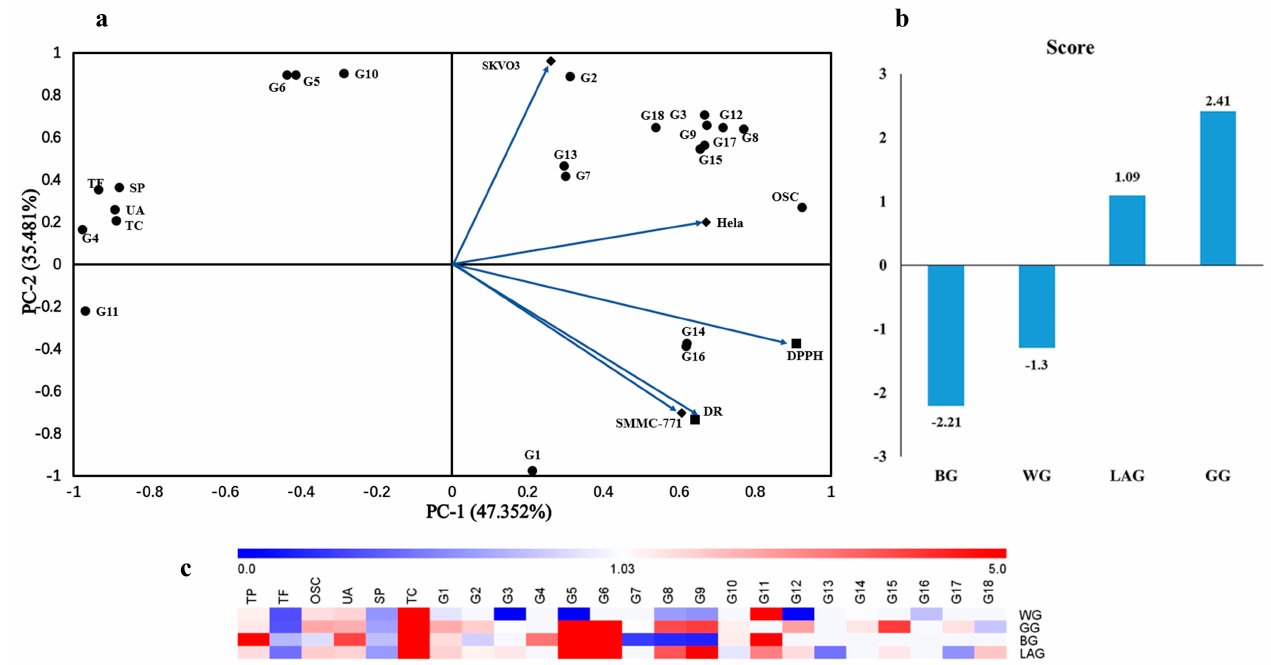
Figure 2. Results of PCA and heatmap analysis ( a ) The component described by two principal components (PC-1) = 47.362% and PC-2 = 35.481% ( b ) The score plots of four kinds of garlic. ( c ) The heatmap correlation of major chemical ingredients of four kinds of garlics.G1: Diallyl disulfide; G2: 2-Hexylthiophene; G3: Allyl methyl sulfide; G4: 1,3,5-trithiane; G5: Allyl-methyl trisulfide; G6: 2-tert-butylhiophenol; G7: Butythiobenzene; G8:1-propene-1,1 (cid:48) -thiobis; G9: Diallyl trisulfide; G10: 3- Acetyl-2,6-heptanedione; G11: Ethyl 4-t-butylbenziate; G12: Diallyl tetrasulphide; G13: 2,5-dimethyl thiophene; G14: Acetyl valeryl; G15: 1,2-Dithiin-3-ethenyl-3,6-dihydro; G16: 10-nonadecanol; G17: Ethyl hexadecanoate; G18: (Z, Z, Z)-9, 12, 15-Octade-catrienoyl ethyl ester; WG: white garlic; GG: green garlic; BG: black garlic; and LAG: Laba